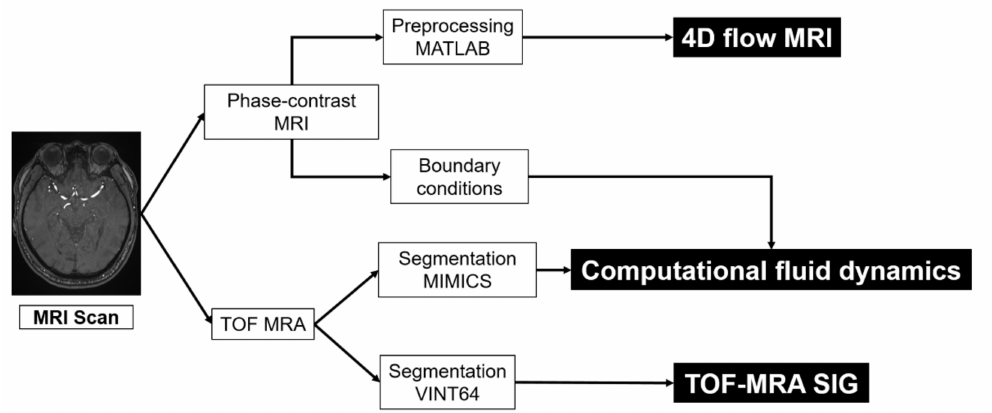
Figure 1. Flow chart of the multi-modality hemodynamic analysis of four-dimensional flow magnetic resonance imaging (4D flow MRI), computational fluid dynamics (CFD), and time-of-flight magnetic resonance angiography (TOF-MRA) signal intensity gradient